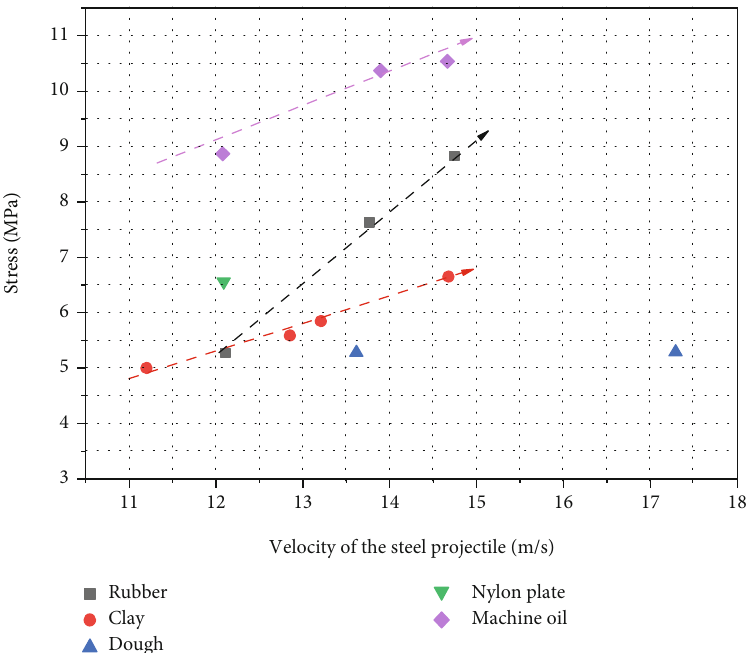
Figure 19: Peak value of stress waves in di ff erent experimental conditions.